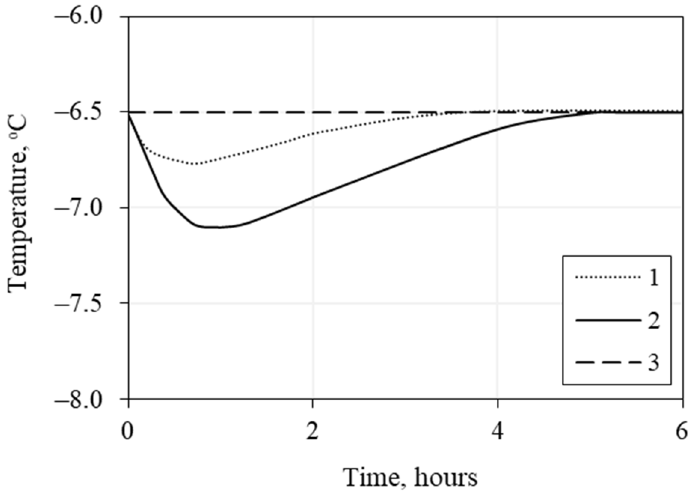
Table 3. Properties of hydrate-free (sample #1) and hydrate-saturated (sample #2) frozen sand.